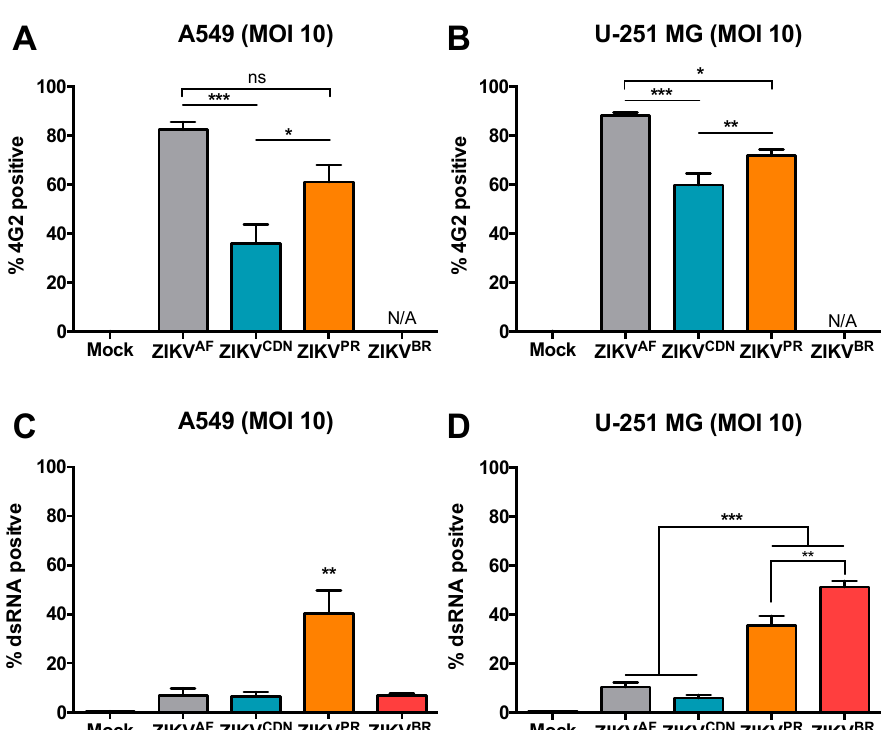
Figure 3. Contemporary ZIKV isolates induce more dsRNA than pre-epidemic isolates, despite similar numbers of infected cells. ( A ) A549 and ( B ) U-251 MG cells were infected with ZIKV at MOI = 10 and at 24 h post-infection cells were stained with the pan-flavivirus (4G2) antibody and the percentage of infected cells was determined by flow cytometry. ( C ) A549 and ( D ) U-251 MG cells were infected with ZIKV at MOI = 10 and 24 h post-infection the percentage of dsRNA-positive cells was determined by flow cytometry. The percentage of positive cells was determined by comparison to mock-infected cells. Values represent mean ± SEM of at least three independent experiments. Asterisks indicate significant differences in % infected cells: * p < 0.05, ** p < 0.01, *** p < 0.001.